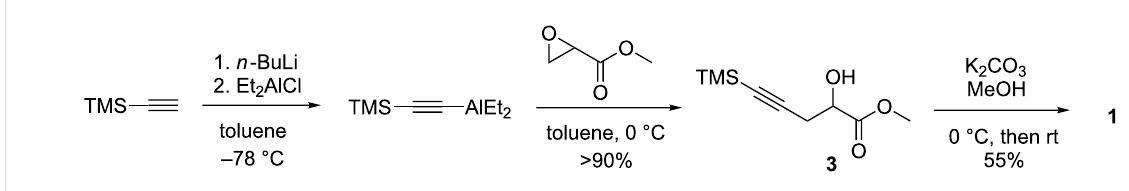
Scheme 2: Synthesis of 1 via epoxide ring opening with organoalane.